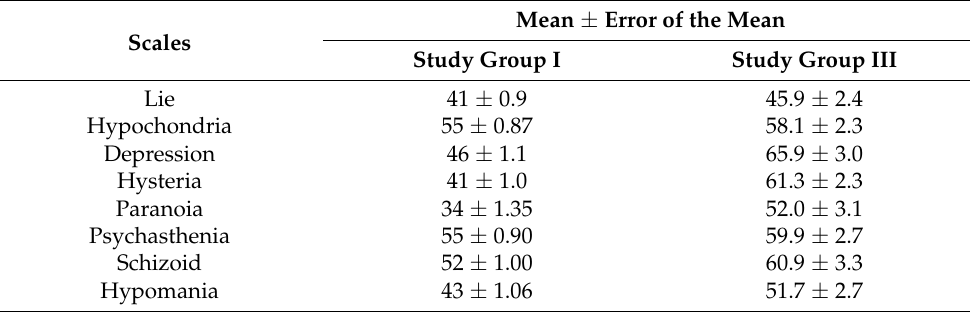
Table 1. Test results according to the Mini-Mult method, as